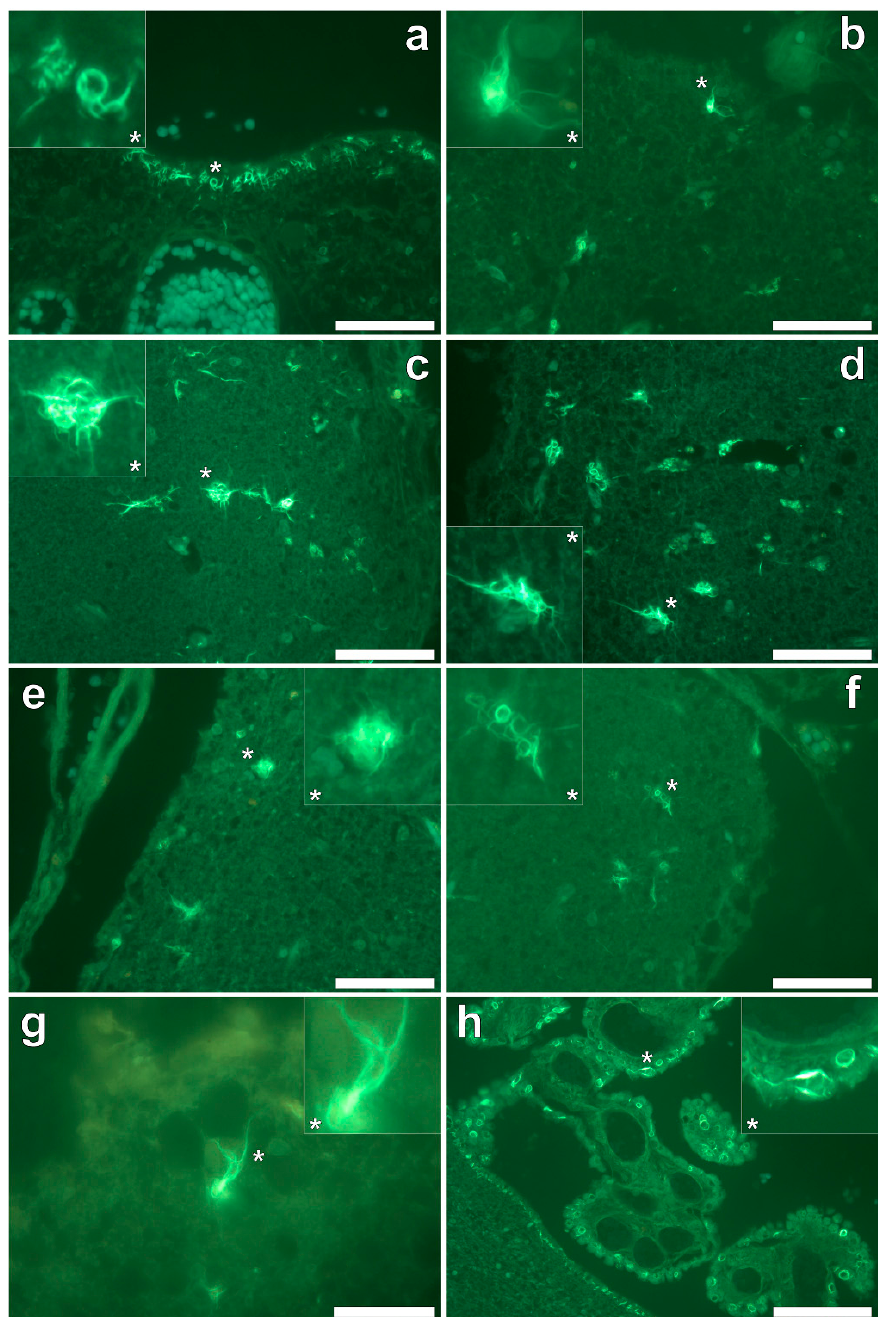
Figure 6. Thioflavin S (ThS) staining of the frontal (a,b), parietal (c,d) , occipital (e,f) and temporal lobes (g) and hippocampus (h) revealed cortical neurofibrillary tangles (NFTs) as highlighted via a green fluorescence emission. ThS-reactive NFTs were noted in pia mater, as demonstrated in the frontal cortex (a) and hippocampus (h) . Ring-like NFTs were also noted in the choroid plexus (h) . Magnified inserts are denoted with asterisks. Magnifications: (a–f) : × 40, (g) : × 1000, (h) : × 200, scale bars: (a–f) : 50 µm, (g) : 20 µm, (h) : 100 µm.